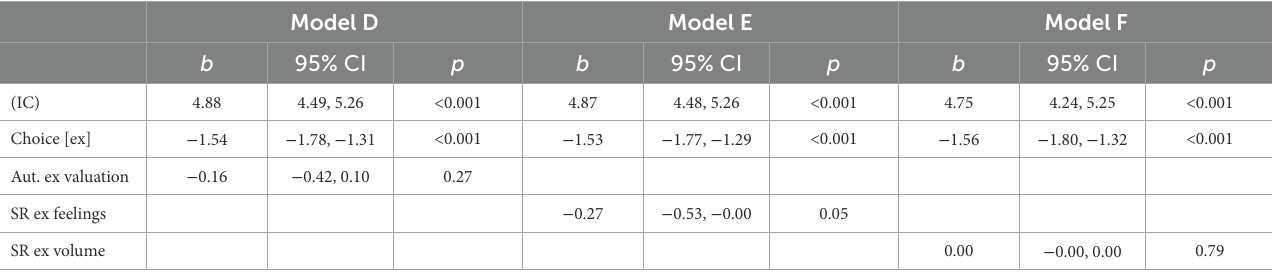
TABLE 3 Predicting non-exercise fixations with automatic valuation of exercise (Model D), self-reported feelings towards exercise (Model E) and self- reported exercise behavior (Model F) when making exercise-related